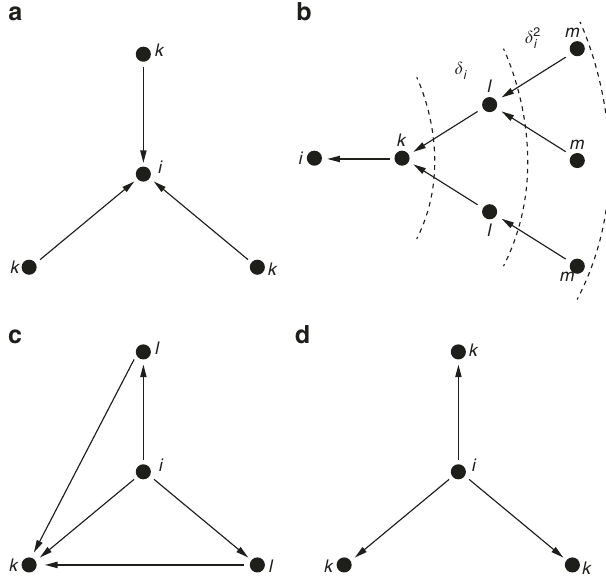
Fig. 1 Sketch of the payoff function ’ s contributions. a The indegree centrality of agent i is determined by the sum of all the incoming ties. b The in fl uence of agent i is computed summing up the weighted paths to the node i , discounted by 1, δ i , δ 2 i . c The clustering coef fi cient of agent i depends on the weighted directed closed triads that surround node i . d The cost to agent i corresponds to the outdegree of node i